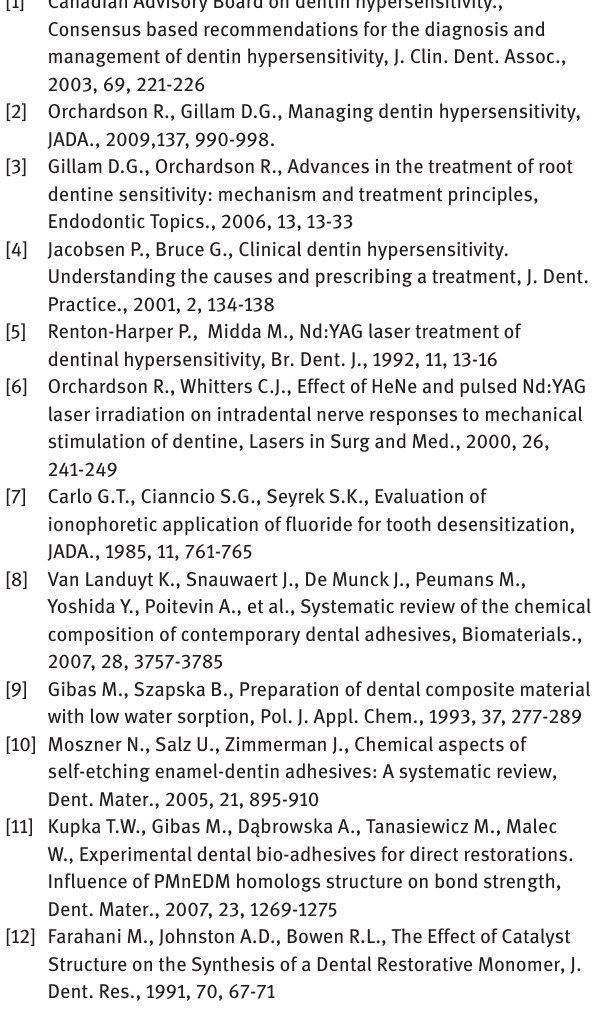
Figure 6: Photograph of polished surface (A) and exposed dentin surface (B) both coated with the experimental material; micrograph of microsection (C), all after